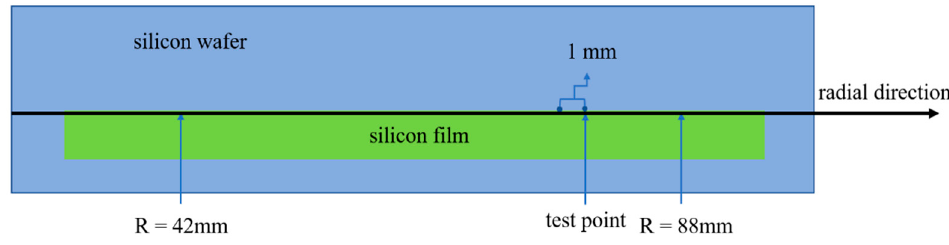
Figure 10. Single point test result.